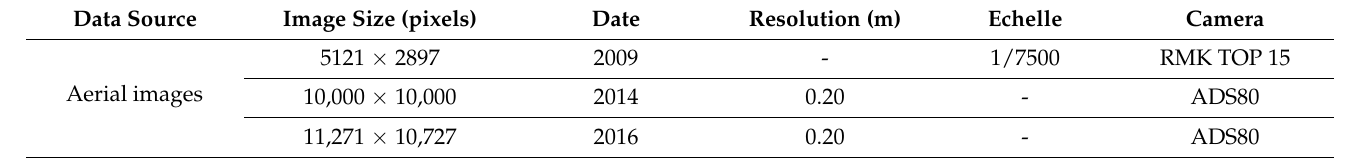
Table 2. Specific parameters of aerial